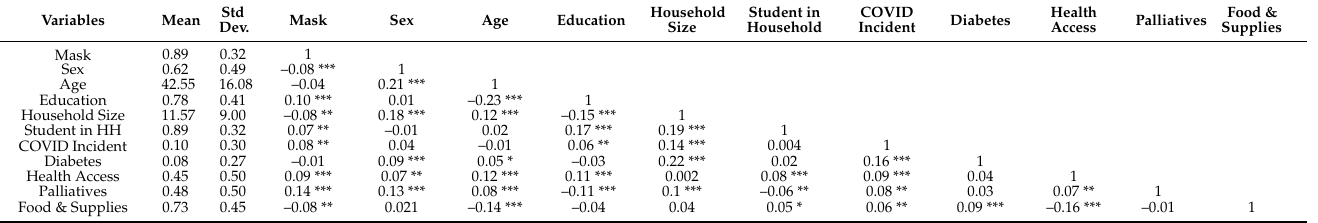
Table 1. Descriptive statistics: Means and correlation matrix. Note: Std. Dev. stands for standard deviation. Variables Mean Std